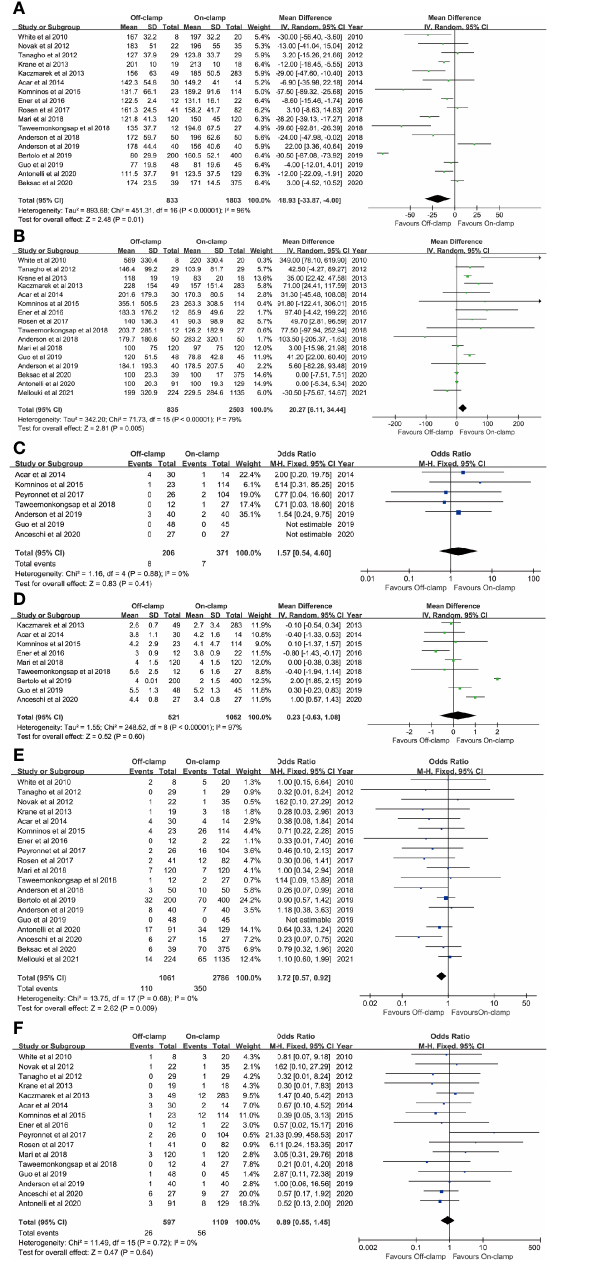
LOS NinearticlesreportedthedataofLOS,including1,573patients(521 off-clamp versus 1,052 on-clamp) (12, 14 – 16, 20, 21, 23 – 25). No signi fi cant difference was detected among the two groups (WMD: 0.23; 95% CI: -0.63, 1.08; p = 0.60), but statistically signi fi cant heterogeneity was observed ( I 2 = 97%, p < 0.00001) ( Figure 2D ).